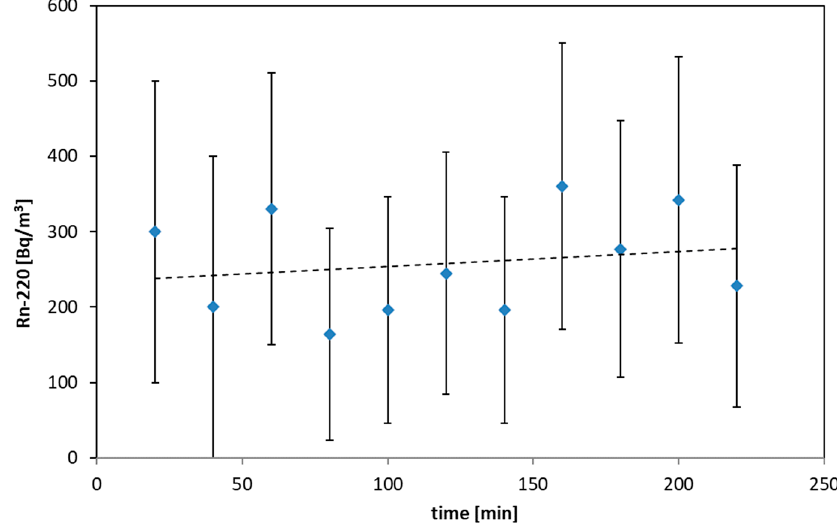
Figure 7. Thoron concentration under accumulation chamber.